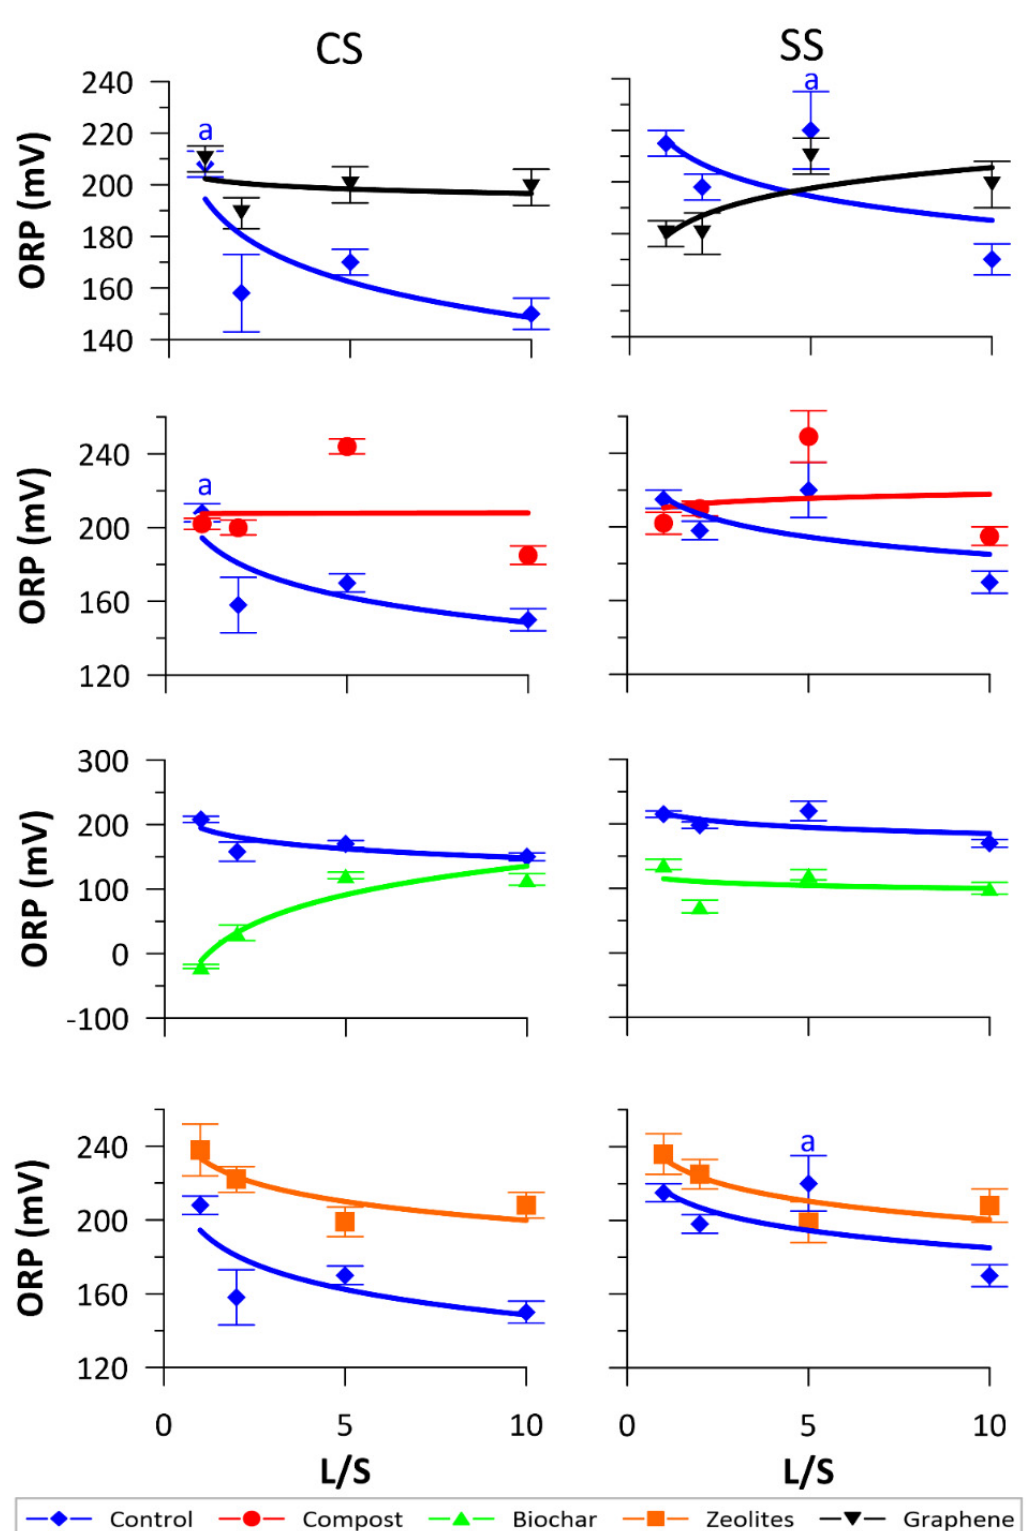
Figure 6. ORP values in SSE batches CS ( left panels ) and SS ( right panels ) soils versus L/S ratios values at the end of the monitoring period. Error bars denote standard deviation calculated on three replicates, while lines are the best fit natural logarithmic curves. Different letters indicate statistically different means at 0.05